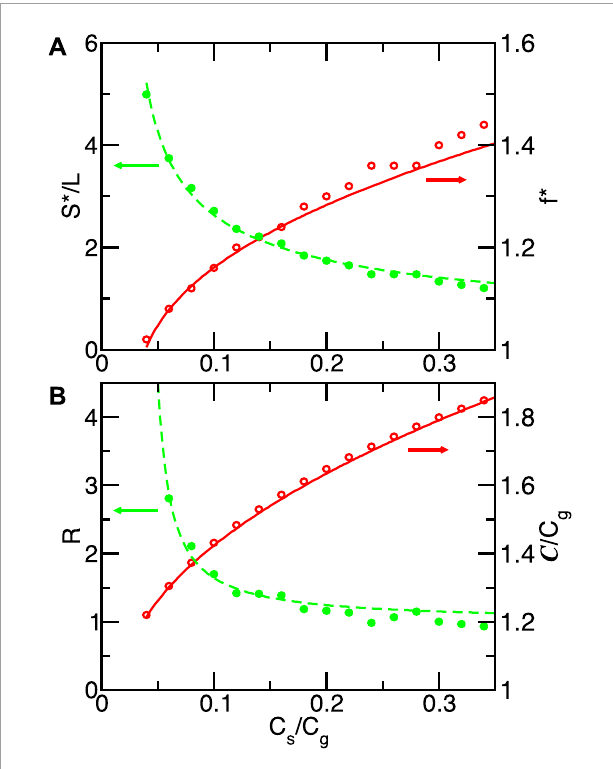
FIGURE 6 (A) Optimal storage value S * and generation capacity f *, as functions of cost ratio C s / C g . (B) Ratio R of storage cost to excess generation cost, and the system cost C , as functions of C s / C g . In both panels, circles are simulation points, while solid lines are the theoretical predictions of Eqs 12 , 15